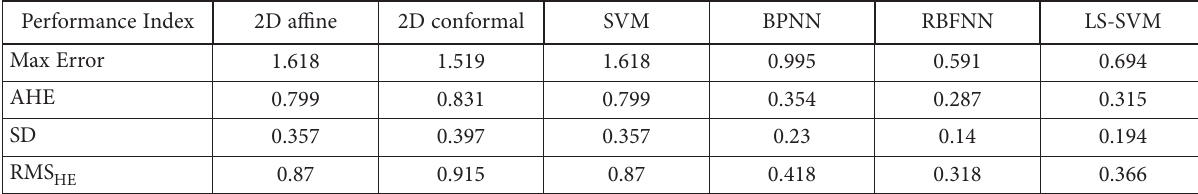
Table 4. Statistics of the total horizontal residuals across the testing data